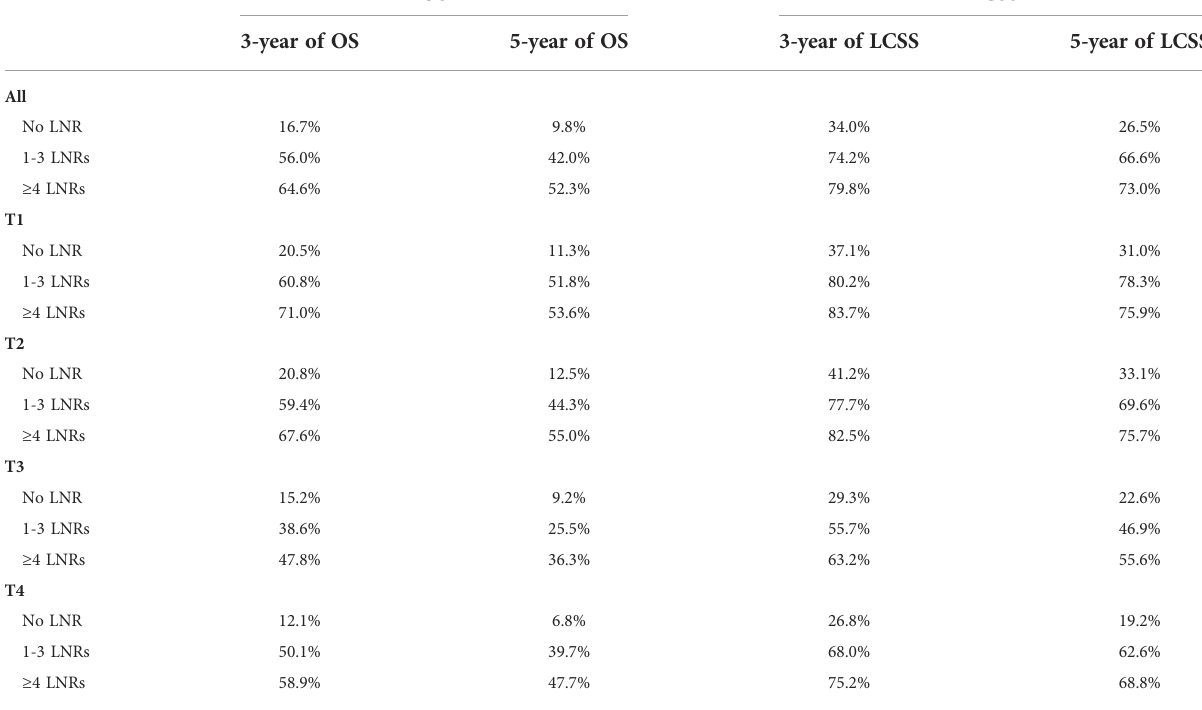
TABLE 2 The 3, 5-year of OS and LCSS of N0 NSCLC